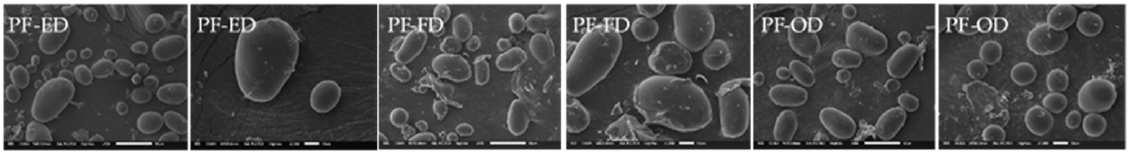
Figure 1. SEM images of potato flour granules subjected to different drying methods. PF-ED: po-